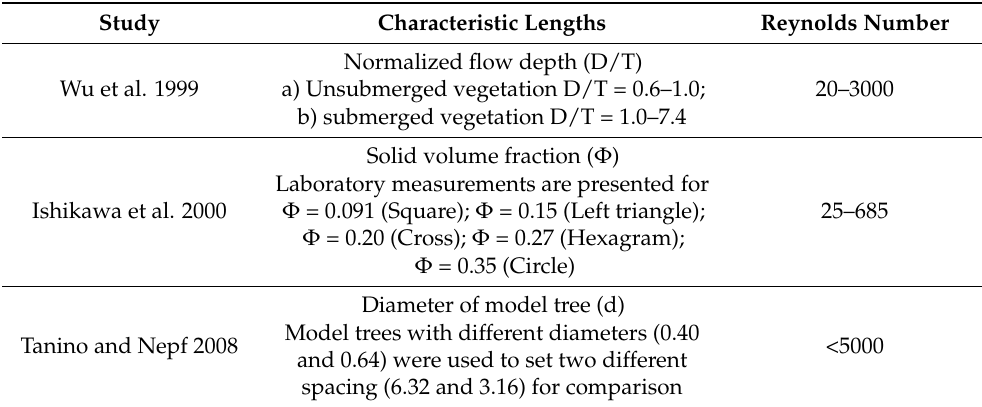
Table 2. Summary of studies that collected different characteristic lengths and Reynolds